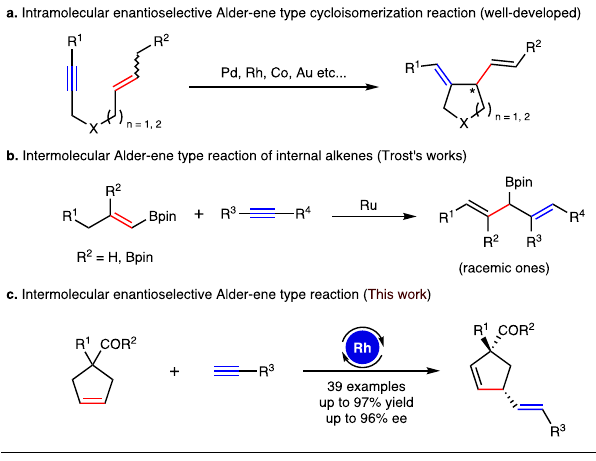
Fig. 1 Transition metal-catalyzed Alder-ene type reaction. a Intramolecular enantioselective Alder-ene type cycloisomerization reaction (well-developed). b Intermolecular Alder-ene type reaction of internal alkenes (Trost ’ s work). c Intermolecular enantioselective Alder-ene type reaction (this